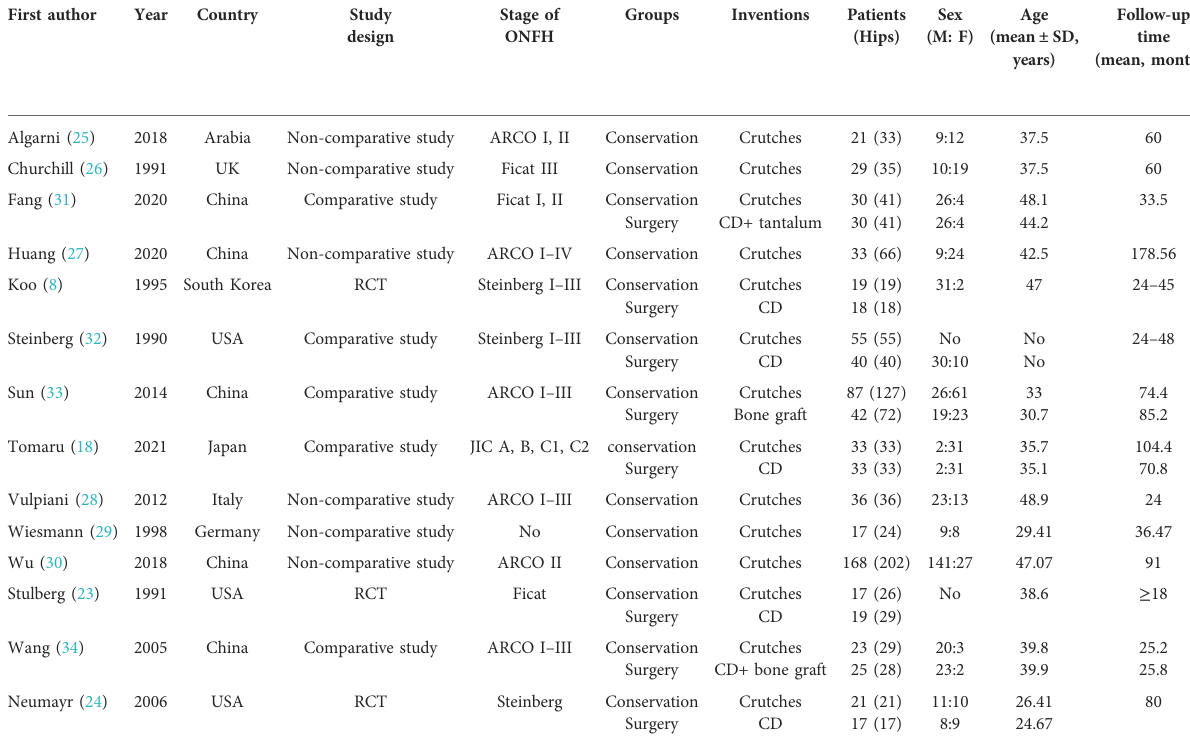
TABLE 2 Baseline characteristics of the included